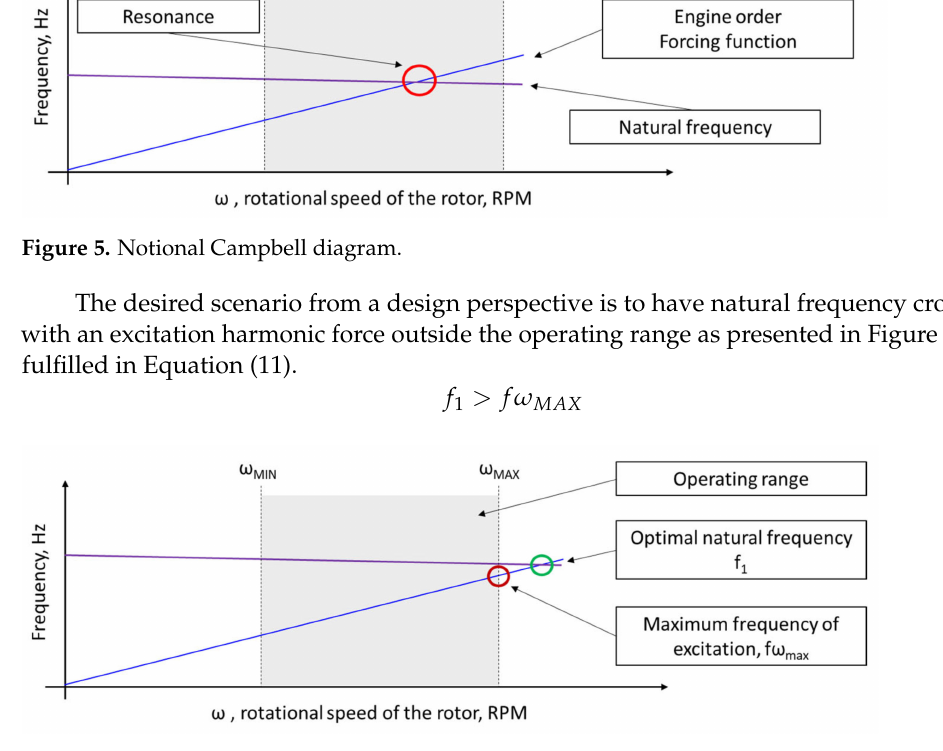
Figure 6. Notional Campbell diagram with optimal location of the natural frequency